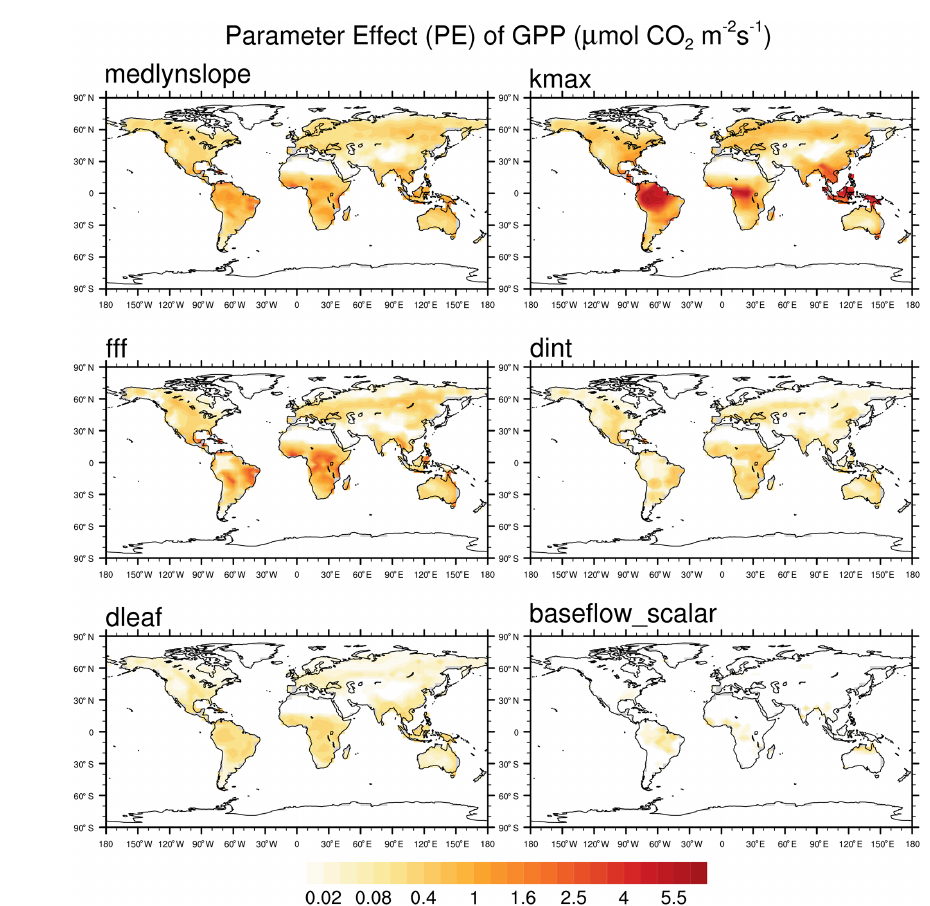
(Table S5). We aim for a balance between parameters